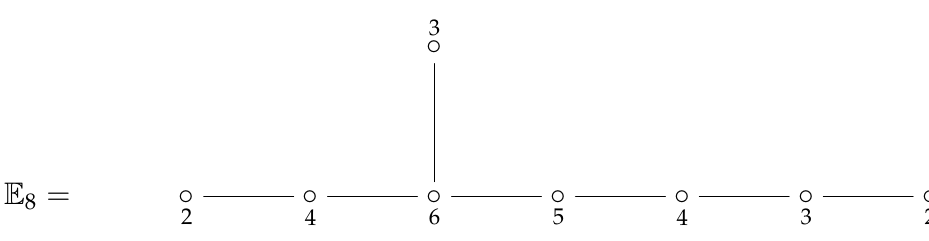
Figure 3. Maximal positive root of the exceptional Dynkin diagram E 8 .